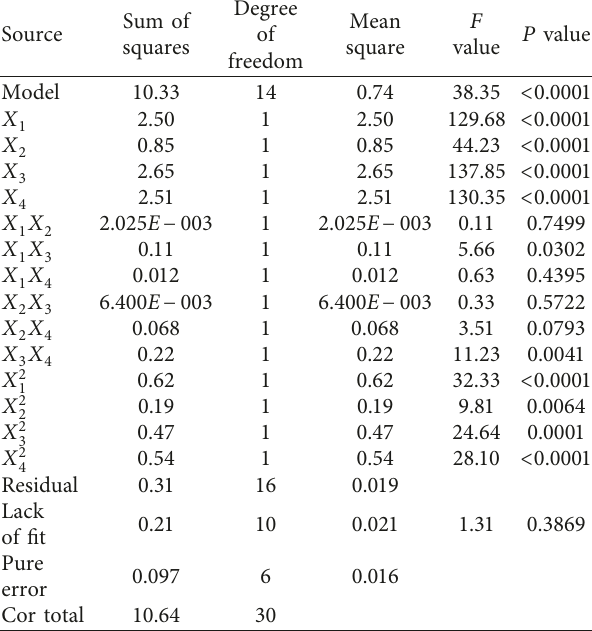
Table 1: Independent variables and their levels used for the CCD. Variables